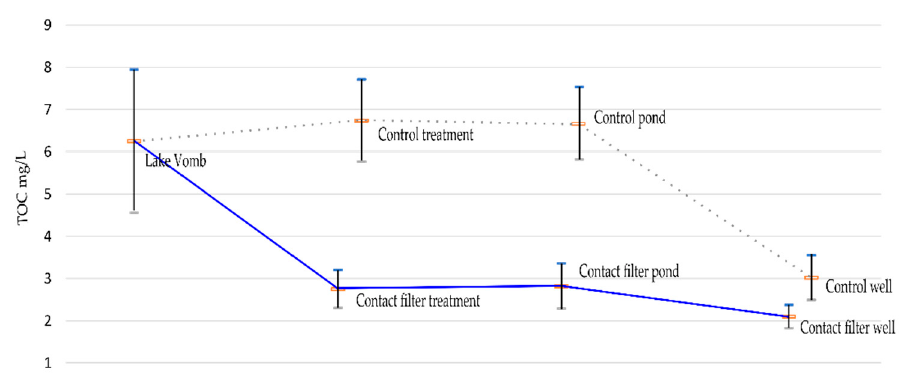
Figure 4. Total organic carbon (TOC) measurements at different stages along the two treatment processes (mg/L). The middle bar is the mean value and the top and lower bars show the standard deviation. The dotted line is the contact filter treatment process and the solid line is the control treatment process.